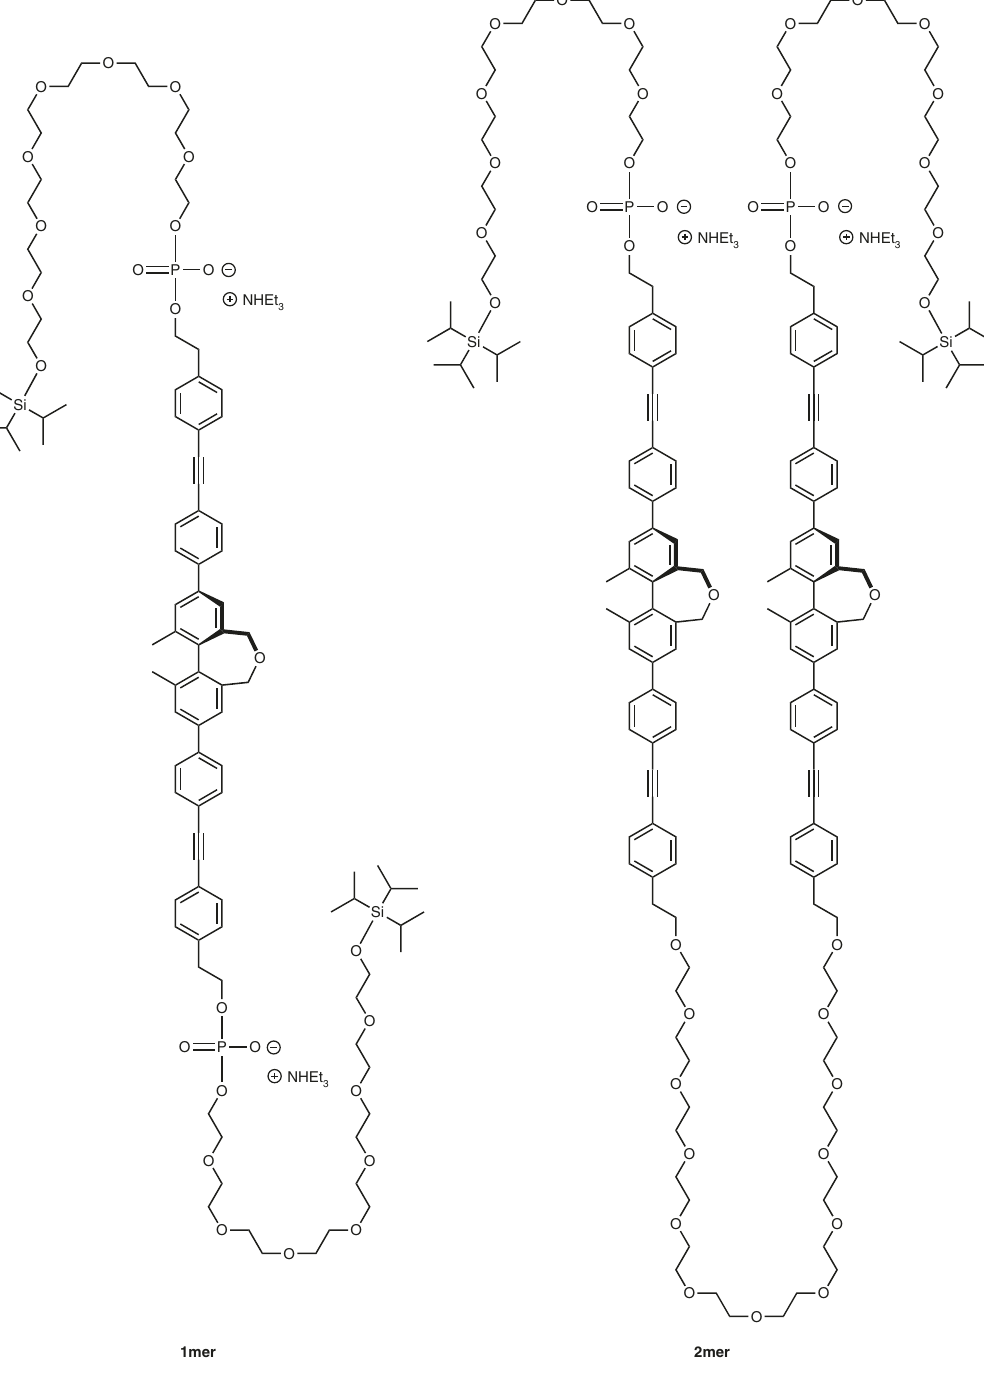
Fig. 1 Molecular structures of multiblock amphiphiles. Molecular structures of 1mer and 2mer